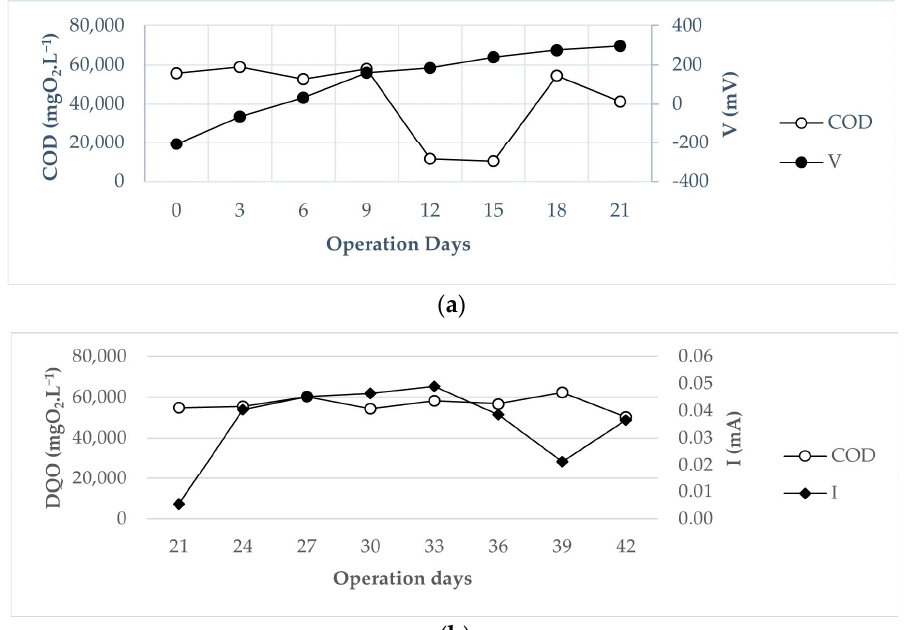
Figure 9. Performance of MFC M4 during 21 days of ( a ) open-circuit operation and ( b ) closed-circuit operation.